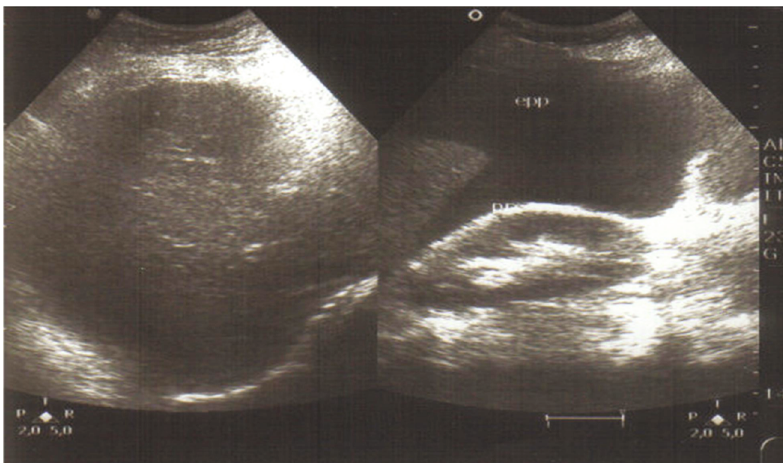
Figure 2: Peritoneal e ff usion of great